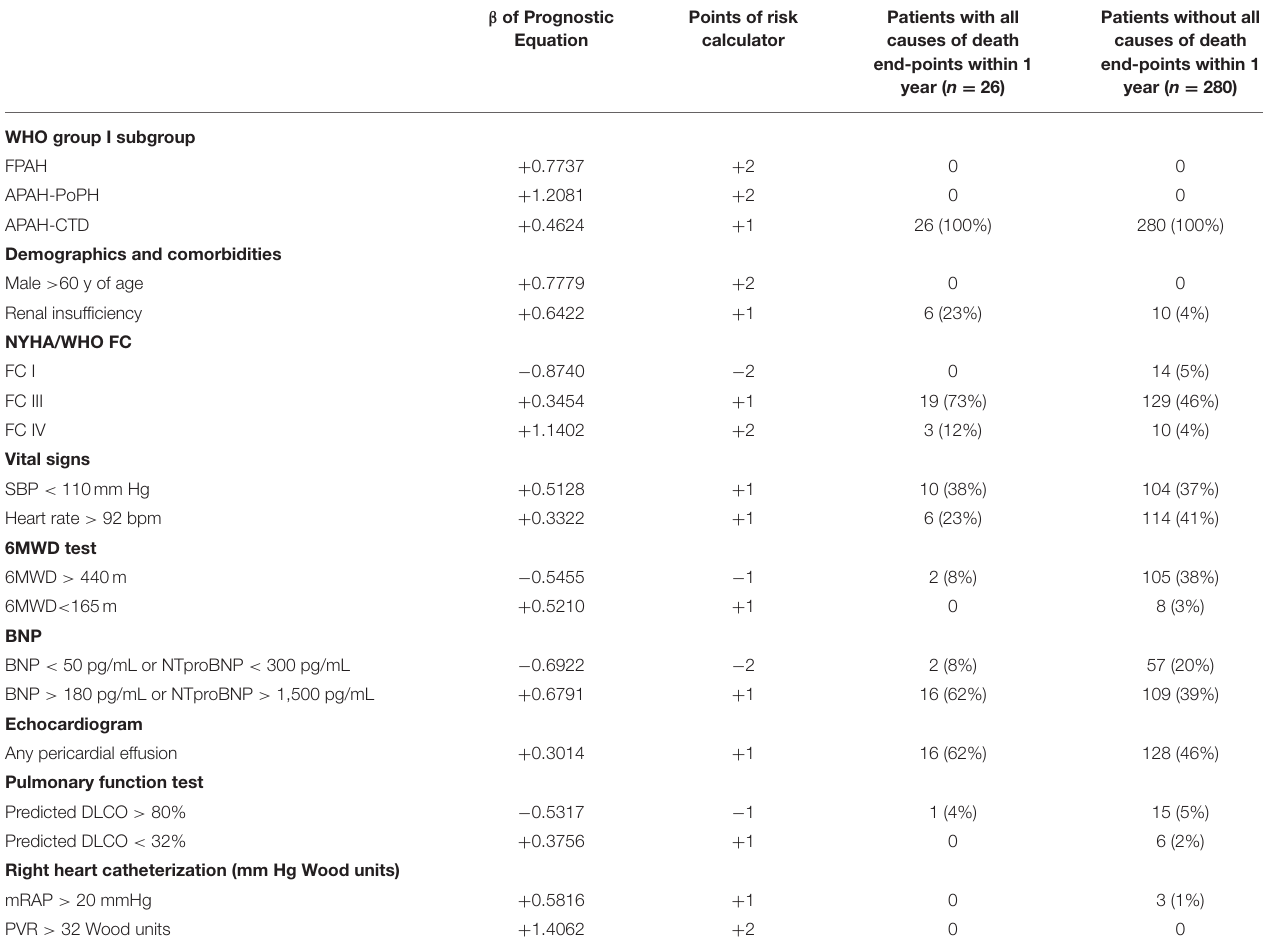
TABLE 1 | Predictors for the REVEAL prognostic equation, simplified risk calculator, and validation cohort.